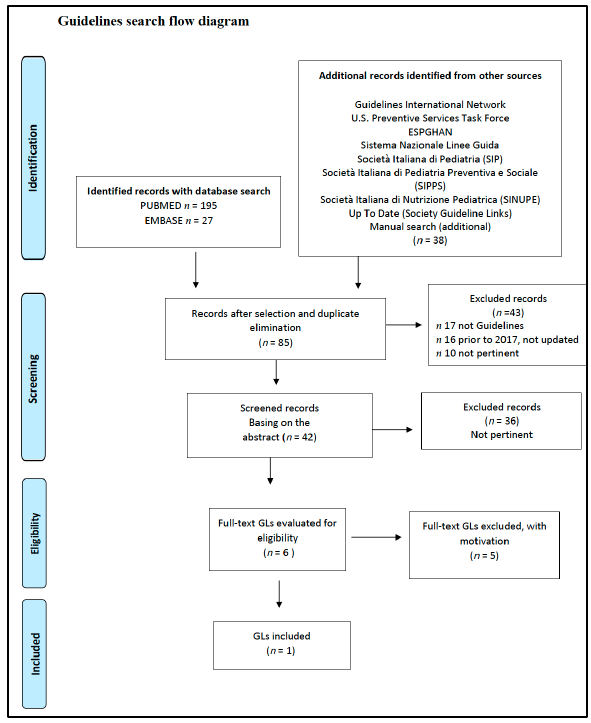
Figure 1. Vegetarian diets and different auxological development and/or growth. Flow diagram of the guidelines search. GL: Guide-Line.